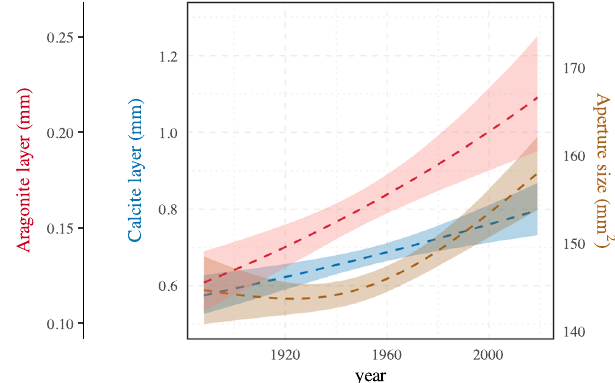
Fig. 7 Generalised Additive Mixed Model shell thickness and aperture trends over the last century. GAMM shell thickness and aperture size trends in the shell of Nucella lapillus collected from the Belgian and Dutch coasts between 1888 and 2019. Shaded areas represent the 95% con fi dence interval.